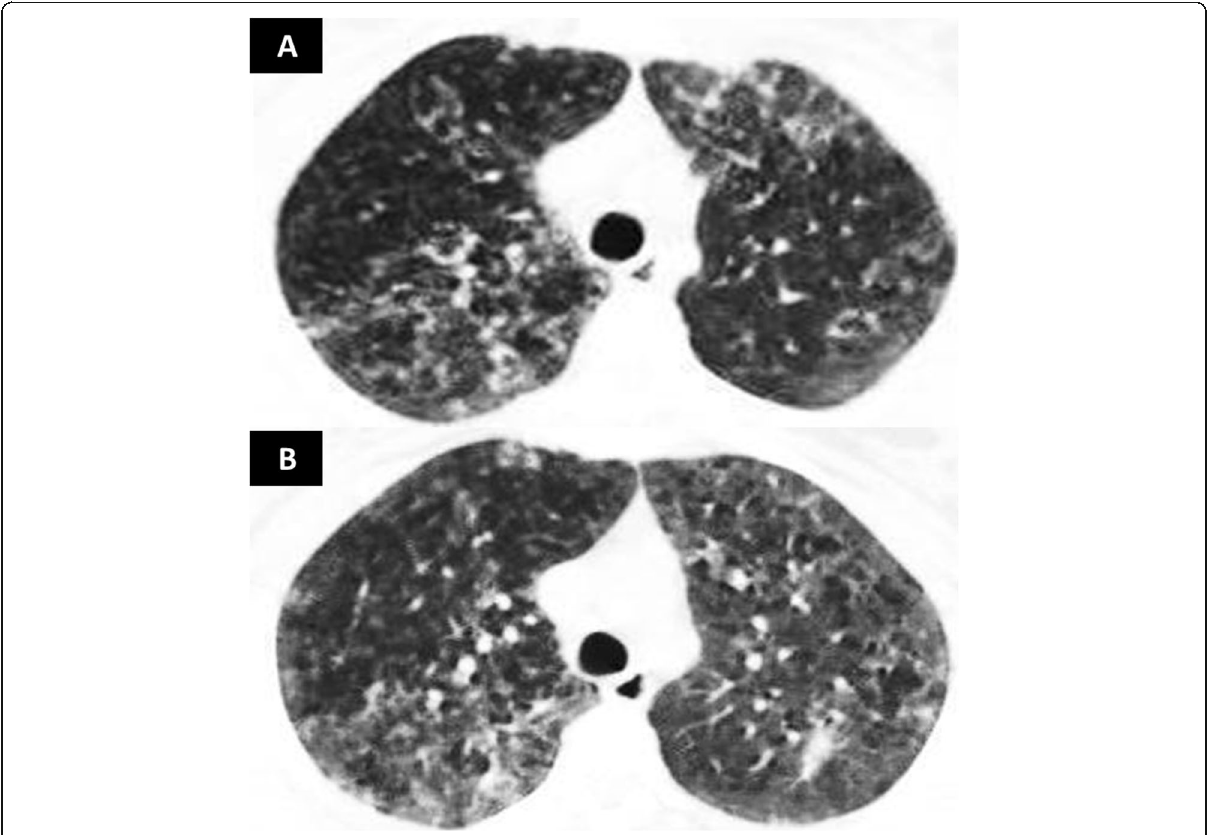
Fig. 1 a An inspiratory axial MDCT image showing ground-glass appearance. b An expiratory axial MDCT images showing areas of air